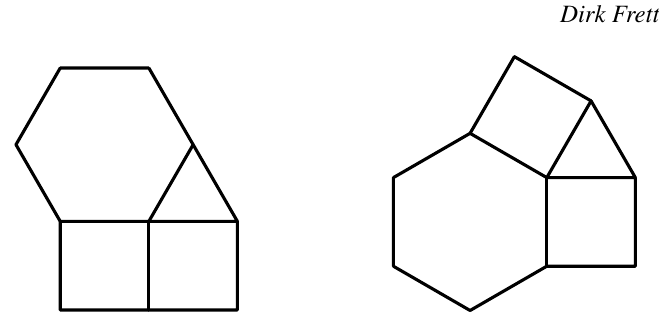
Fig. 1: Two theoretical cases of local structure with triangle, two quadrilaterals and hexagon.